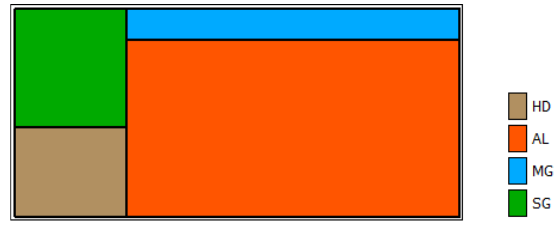
Figure 8. Lithological rule.